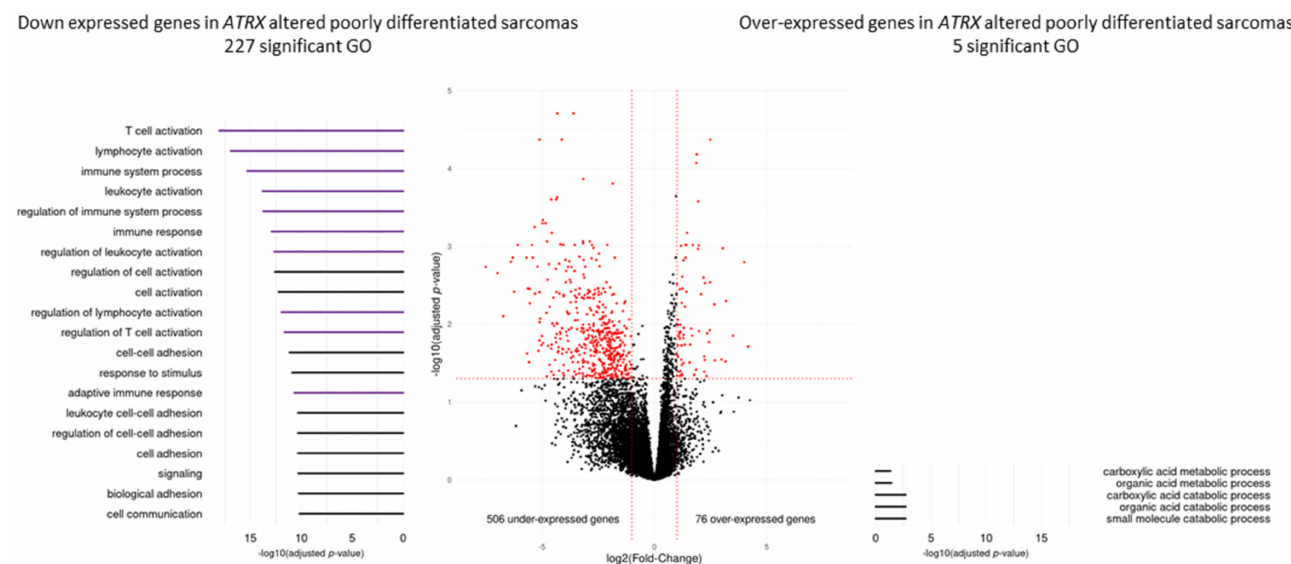
Figure 4. Differential gene expression and Gene Ontology analyses according to ATRX status (wild-type vs. altered) in poorly differentiated pleomorphic sarcomas (Cohort 2). Differentially expressed genes in ATRX -altered tumors are represented in red ( p ≤ 0.05 and fold-change ≤− 2 or ≥ 2). Gene Ontology (GO) analyses, represented on the left (under-expressed genes) and the right (over-expressed genes), identified 227 and five significant GO terms ( p ≤ 0.05), respectively. On the left, the 20 most significant GO terms are represented and color-coded by mechanism; purple and black groups indicate “immunity system process” and general terms, respectively. All p -values were adjusted by Benjamini and Hochberg method.